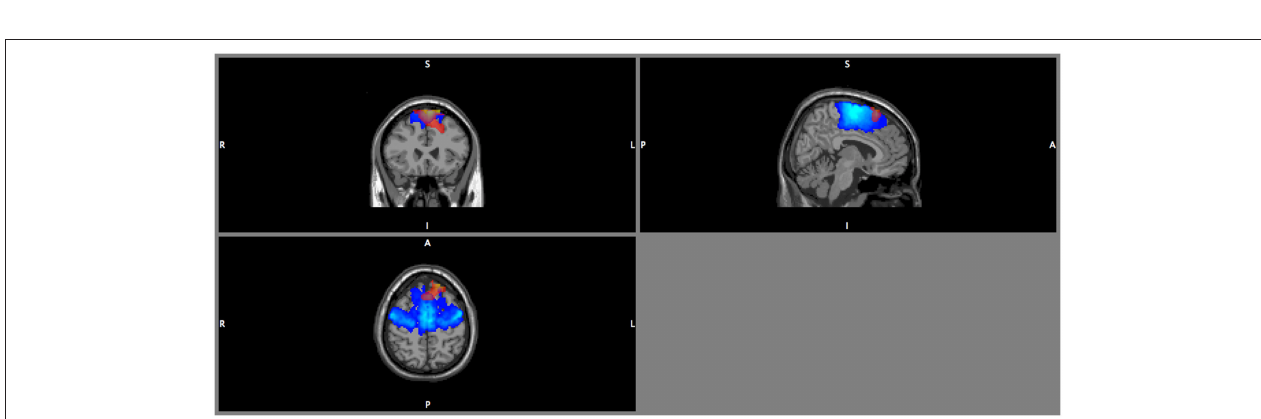
FIGURE 7 | DICS beamformer results for the contrast walking vs. sitting at 18Hz. Red color intensity indicates t -values at |t| > 4.5, blue color indicates the probability map for the left and right premotor areas. Note that the radiological convention was used (i.e., left is displayed right).